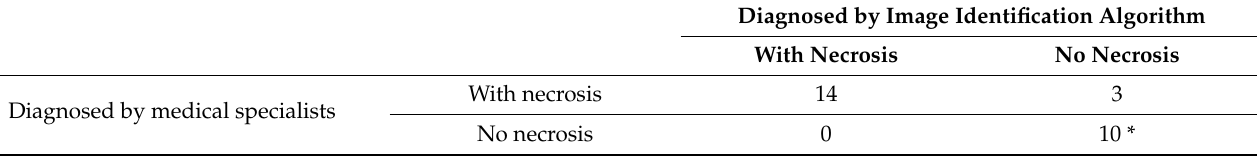
Figure 1. Twenty-seven cases aligned on the chart with black and white pixels. The 27 cases analyzed were divided into four groups on a plane represented by the white pixel percentage and black pixel percentage: black necrosis group (black circle), slough group (yellow circle), white necrosis group (white circle), and no necrosis group (blue circle), based on physician judgment. The patients were divided into four groups. By setting the threshold value to 5% black pixels (red dotted line), the sensitivity and specificity were 82.4% and 100%, respectively. Table 2. The result of determination of necrosis ( n = 27) with medical specialists vs. image identifica- tion